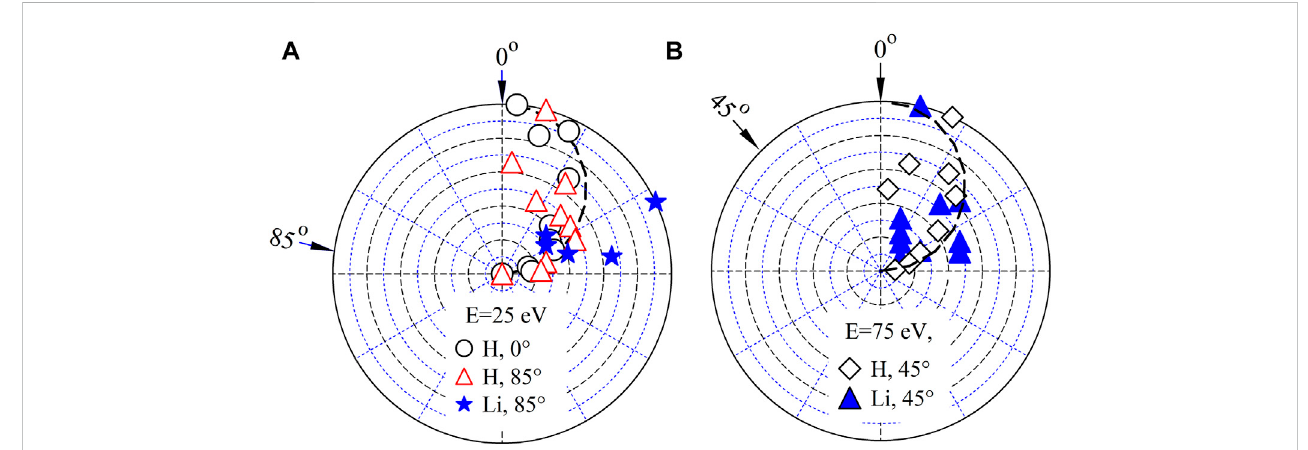
FIGURE 11 AngulardistributionsofHandLiparticlessputteredbyimpactofHatomsfroman (A) LiHsurfaceat300 K,withimpactenergiesof (A) 25 eVand (B) 75 eV. The dN/d Ω valuesinthepolardiagramsarenormalizedtotheirrespectivemaximumvaluesateachimpactenergy.Lambert ’ scosinelawisshownbyadashed